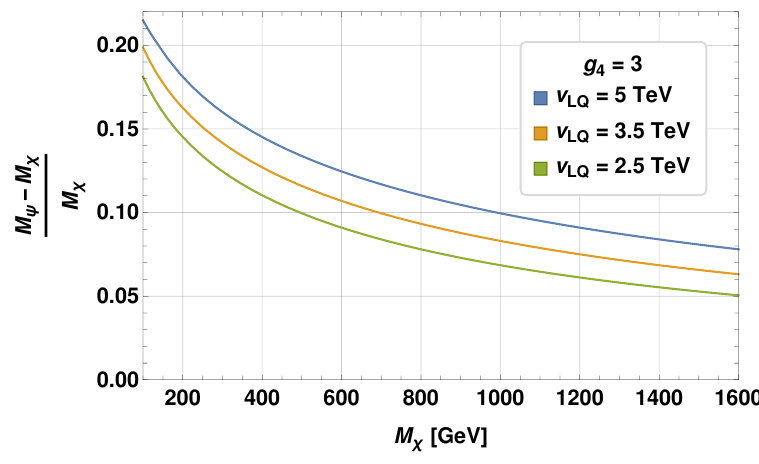
Figure 2 . Mass splitting between and (cid:31) induced by the 4321 gauge